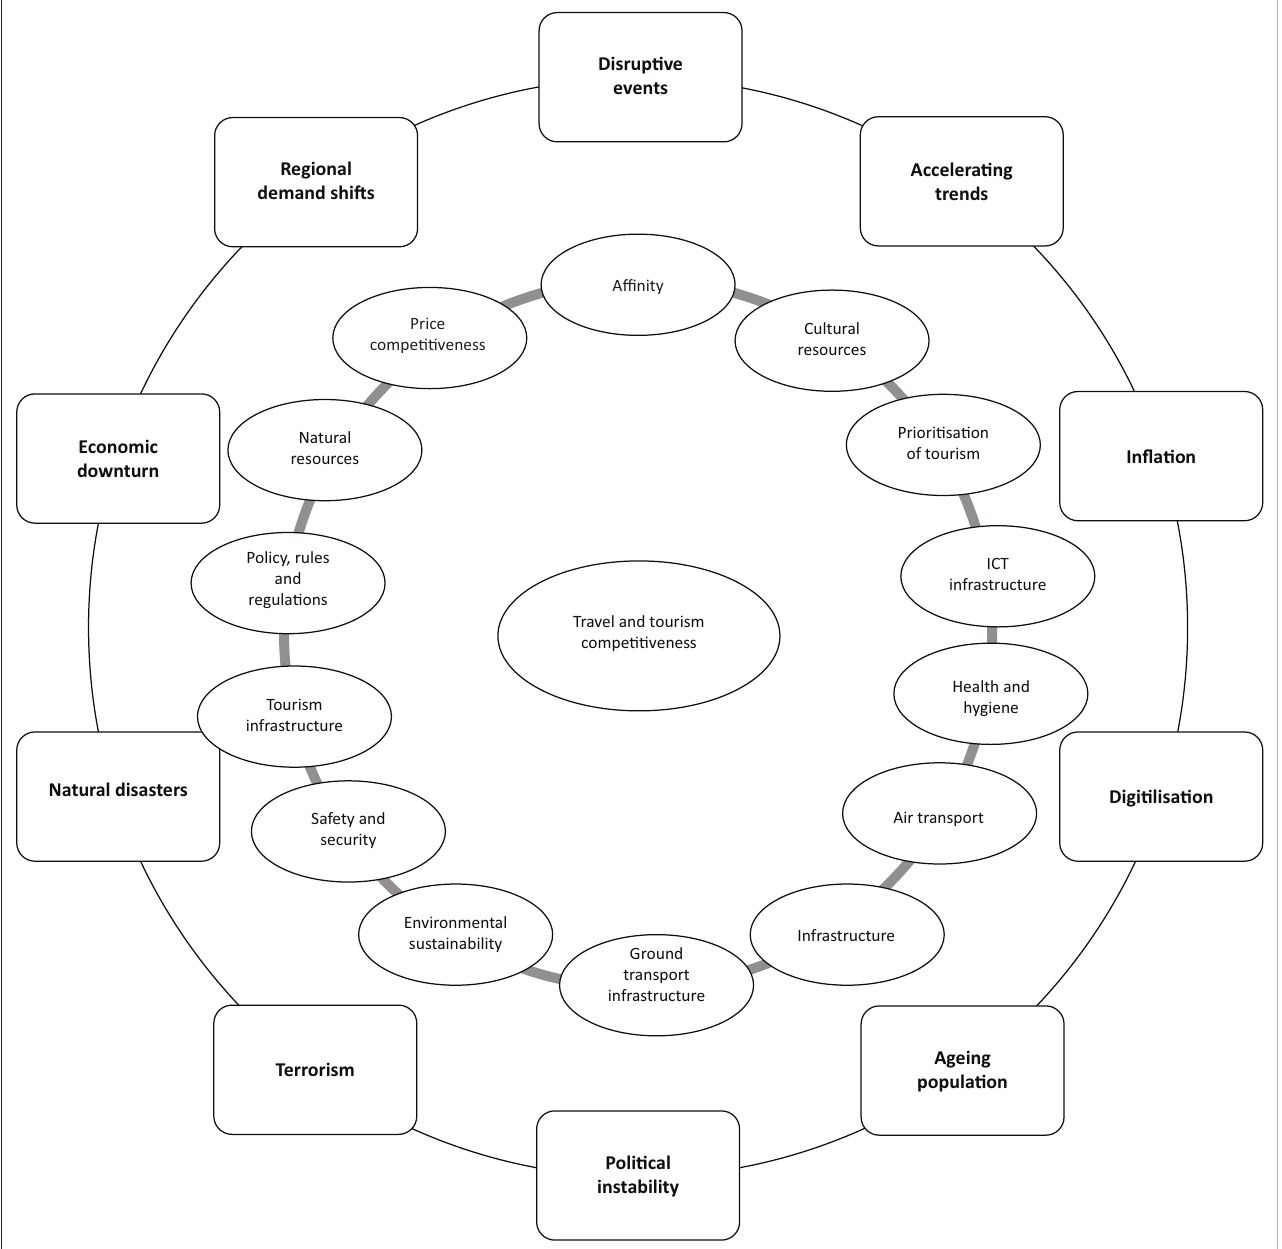
FIGURE 2: The internal and external attributes of